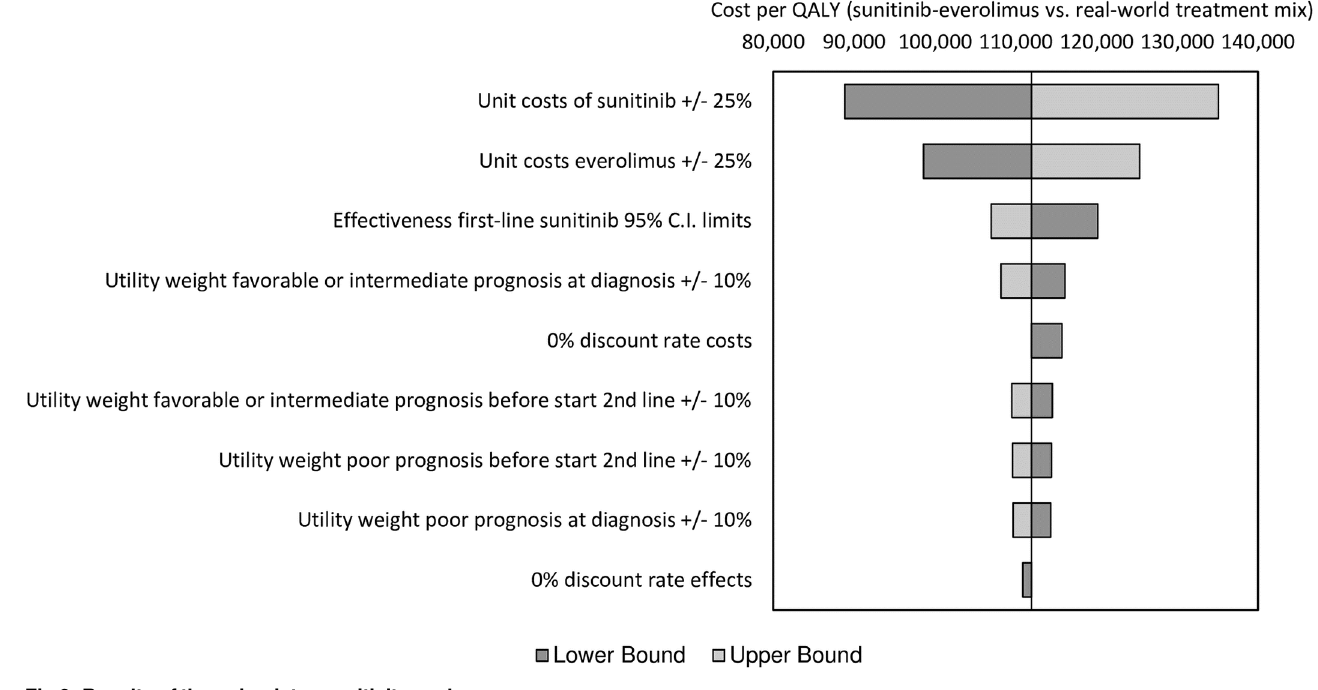
Fig 2. Results of the univariate sensitivity